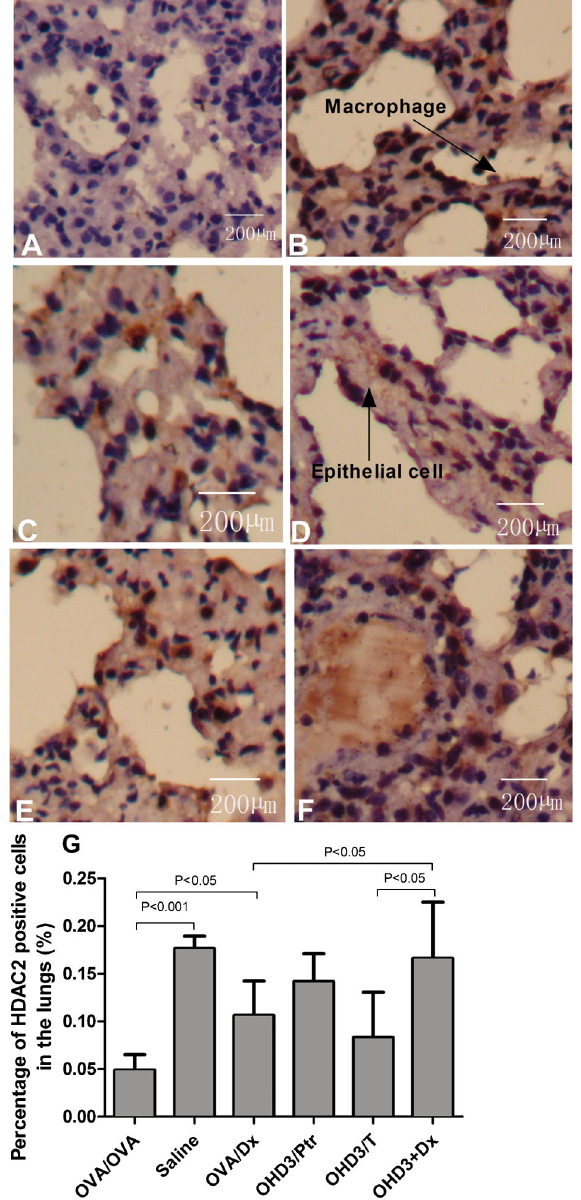
Figure 6. Immunohistochemical study of the localization of histone deacetylase 2 (HDAC2) in the lungs. A , OVA/OVA; B , saline; C , OVA/Dx; D , OHD3/Ptr; E , OHD3/T; F , OHD3++Dx; G , effect of different treatments on the percentage of HDAC2 positive cells in the lungs (%). ANOVA and Student-Newman- Keuls tests were used for statistical analyses. OHD3/Ptr: 1,25(OH) 2 D 3 pretreatment group; OHD3/T: 1,25(OH) 2 D 3 treated group; OVA/OVA: asthma group; OVA/Dx: dexamethasone treated group; saline: the control group; OHD3++Dx: dexametha- sone and 1,25(OH) 2 D 3 treated group.